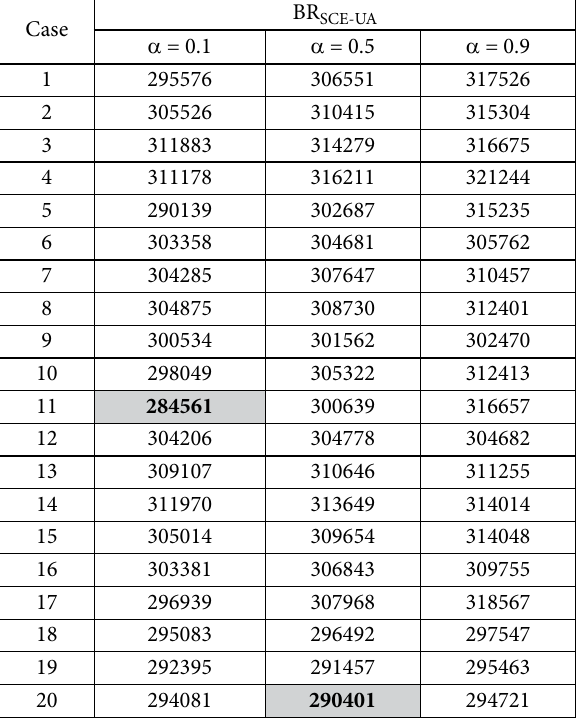
Table 8. Results of cases with different confidence level α